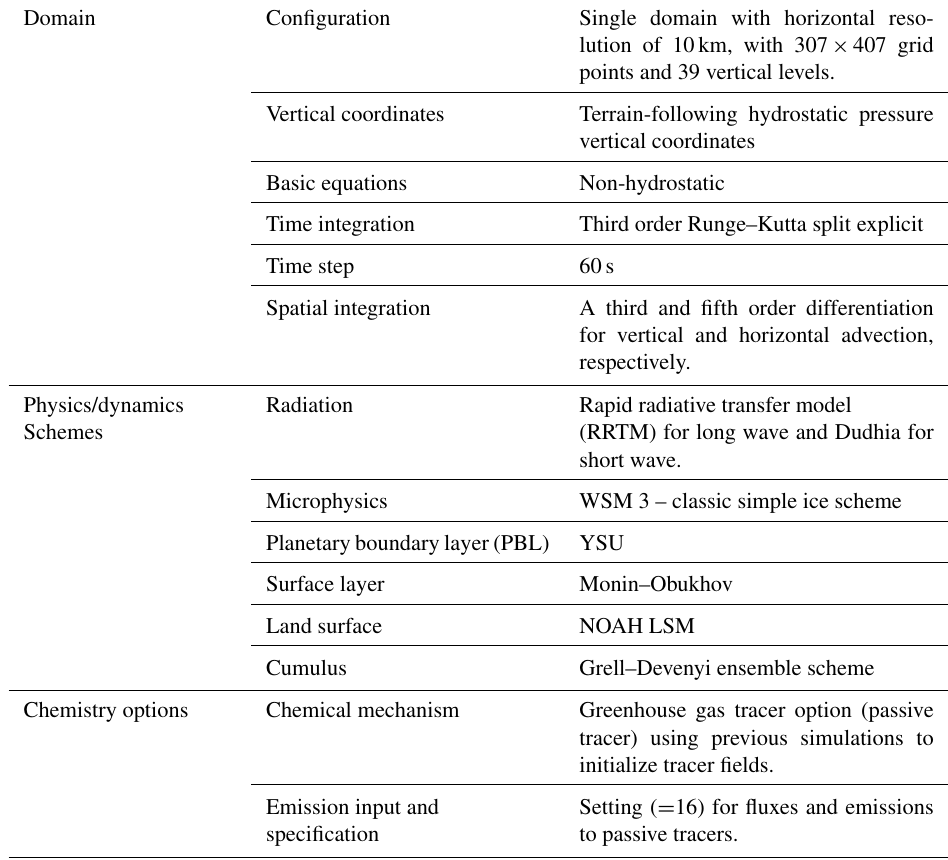
Table 3. Overview of WRF–Chem model set-up. Domain Configuration Single domain with horizontal reso-